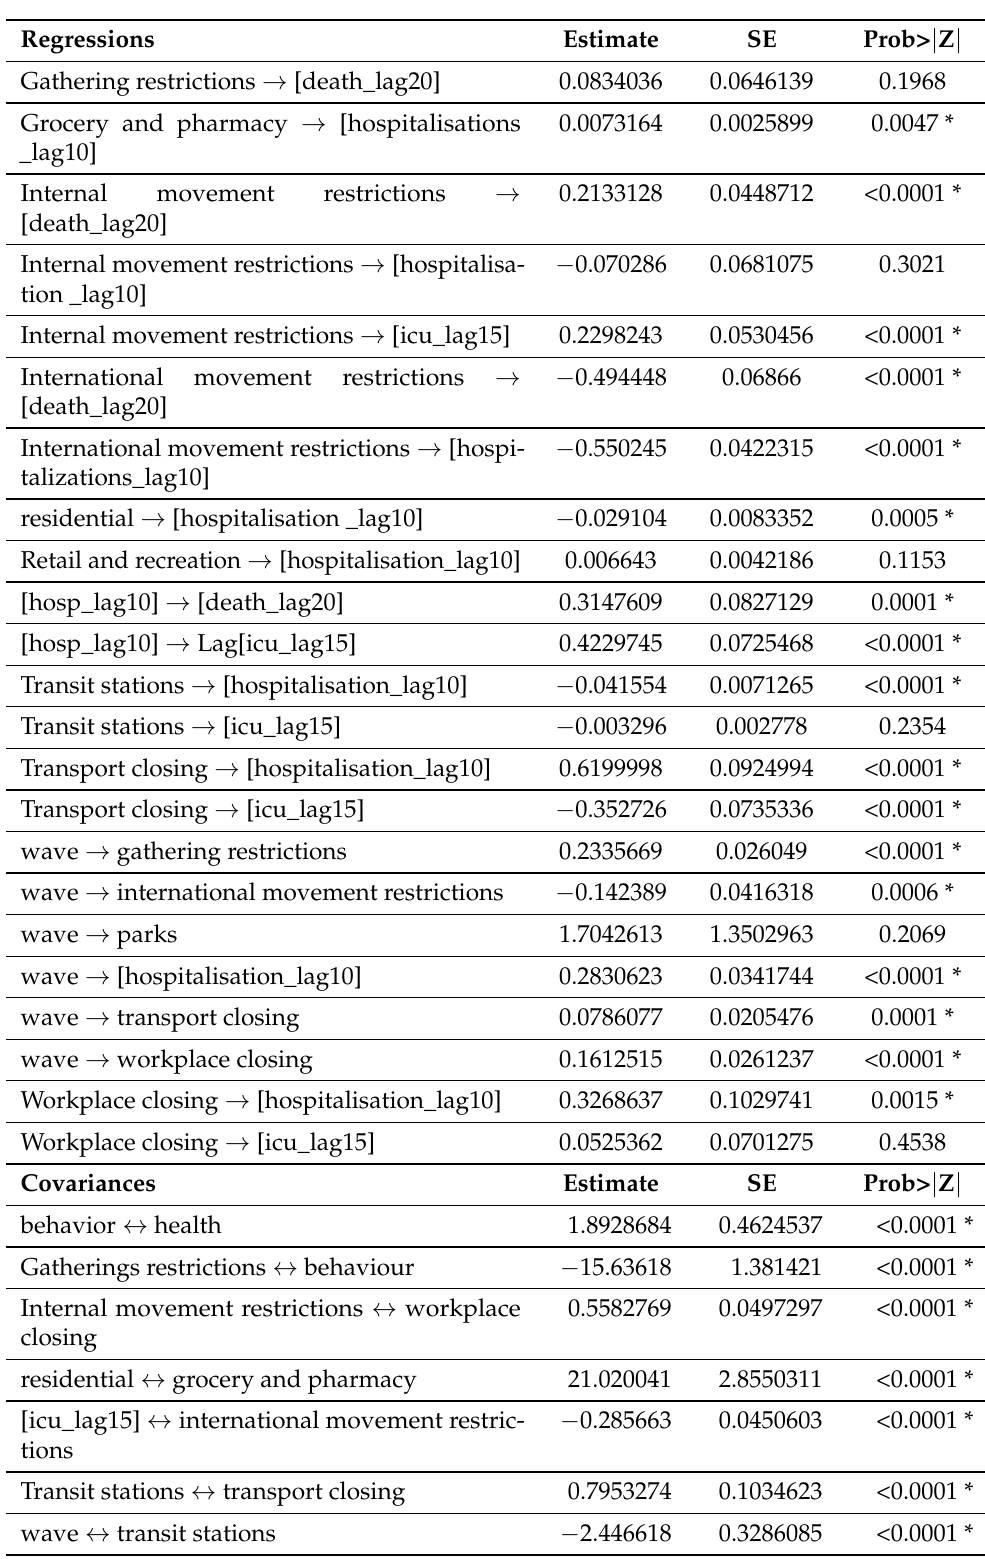
Table 3. Loadings, regressions and covariances for the Israeli data (JMP Pro Version 16). * < 0.05.